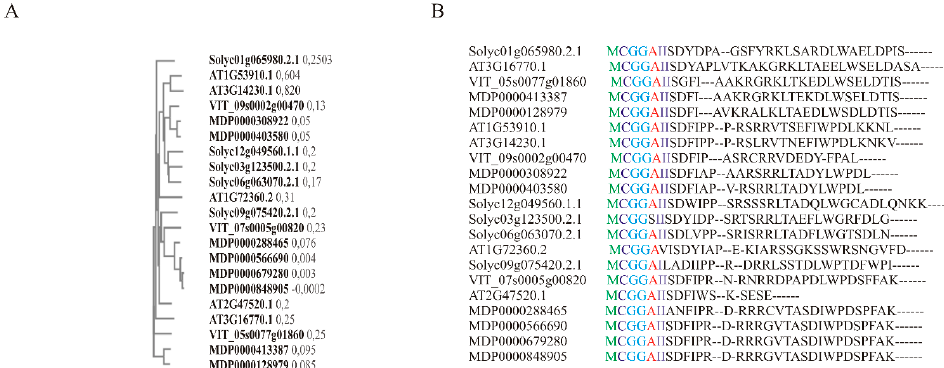
Figure 1. ERF-VII protein sequence similarity among Arabidopsis , tomato, grapevine, and apple fruit. ( A ) Between-species phylogenetic tree representing relationships among ERF-VII proteins (represented values are real distance). ( B ) Multiple sequence alignment of ERF-VII proteins. Conserved MCGGAI amino acid sequence can clearly be seen. This amino acid sequence is recognized by the enzymes involved in the N-end rule pathway. Multiple sequence alignments were performed using Clustal Omega software (EMBL-EBI, September 2018).